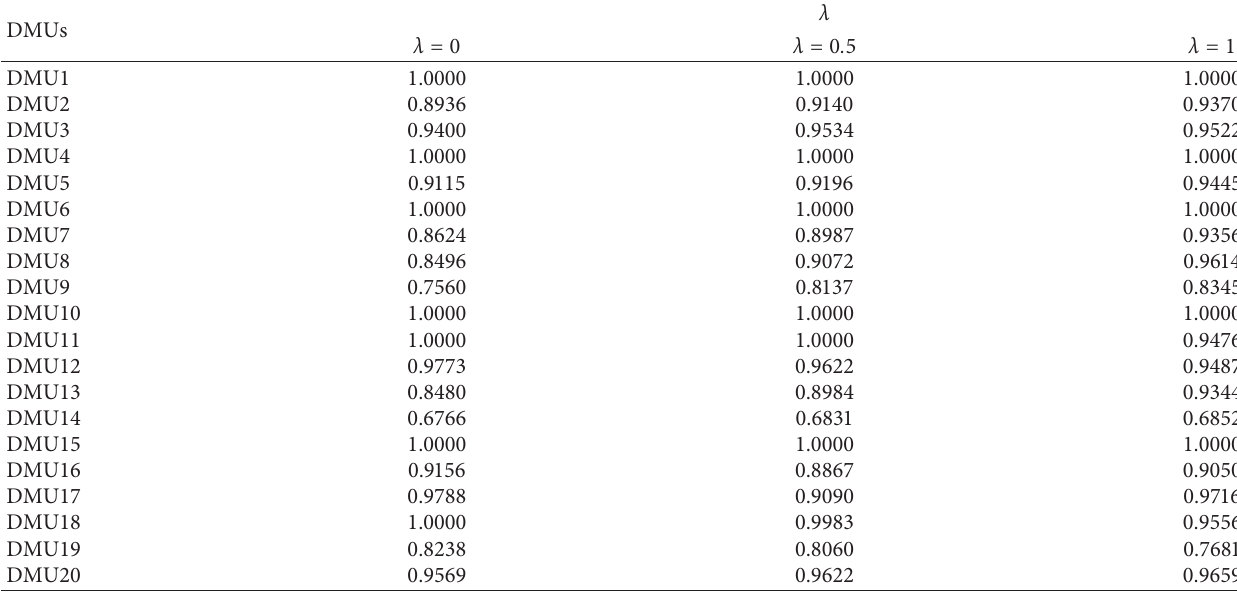
Table 3: The relative efficiency of DMUs for enablers’